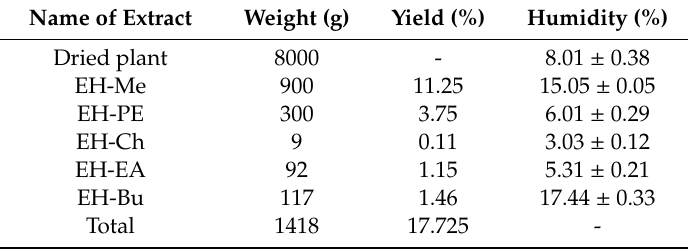
Table 1. Weight and yield of extract after liquid–liquid